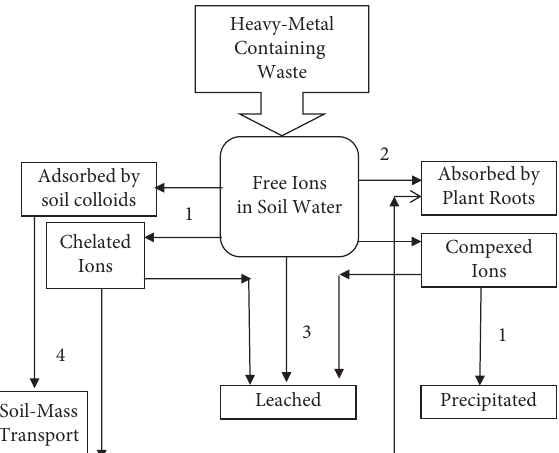
Figure 11: The possibilities of the waste-origin Cu and Zn removals from soil labile fractions after waste amendment (1: adsorption or precipitation, 2: absorption by plant roots, 3: leaching, 4: soil mass transport) [50,